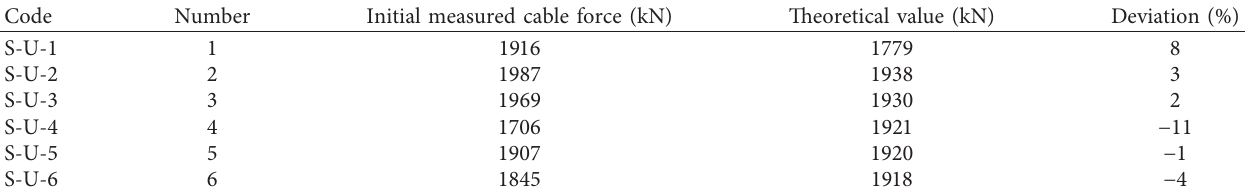
Table 1: Measured values of suspender cable forces before cable adjustment (suspenders no. 1 ∼ 6 in the upstream of the south bank).